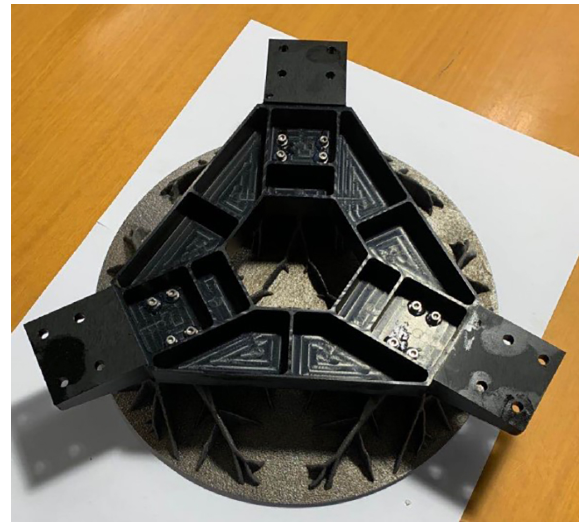
Figure 10. Φ 260 mm aperture aluminum alloy mirror assembly.